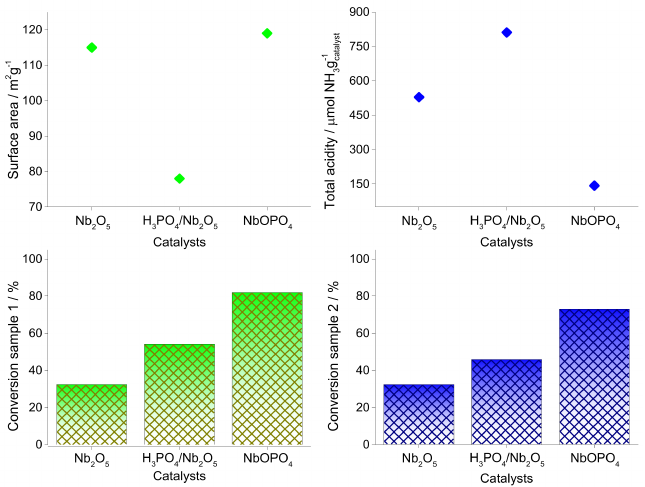
Figure 39. Oleic acid descarboxilation by Niobium catalysts and its surface area and total acid- ity. Reaction conditions: reactant flow (20.5 g h − 1 , catalyst (5 g), temperature (350 ◦ C), time (sample 1 = 30 min; sample 2 = 60 min) (adapted from [73]).